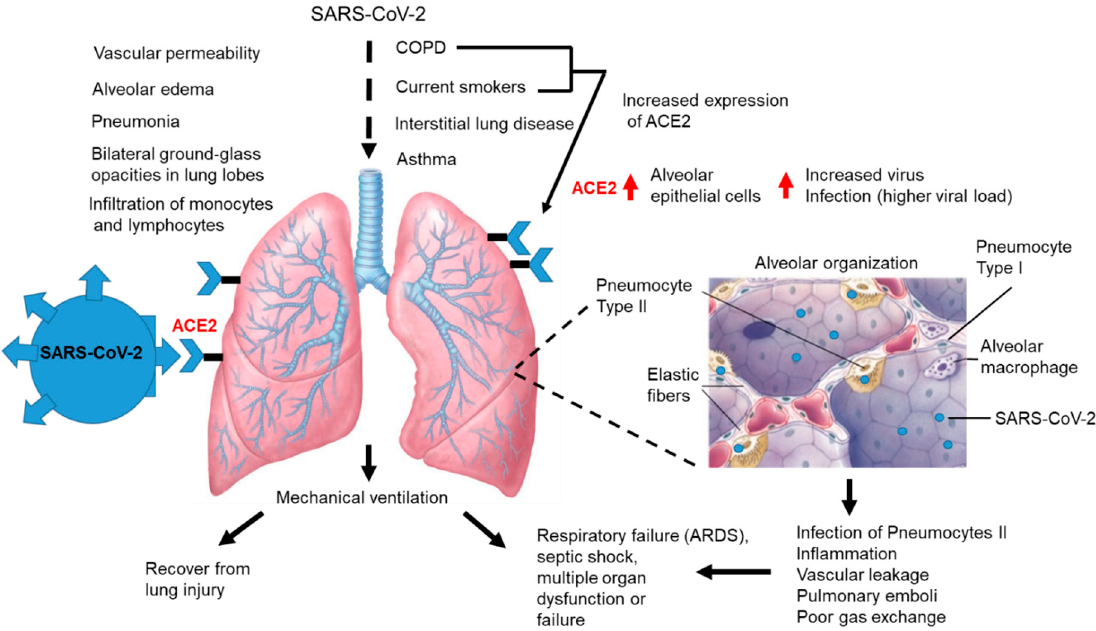
Figure 4. Lung disease and increased risk for severe COVID-19 disease. Hypothetical model of patients with pulmonary disease and increased risk for complications due to COVID-19. SARS-CoV-2 infection via ACE2 entry into alveolar epithelial cells in patients with COPD who smoke may lead to increased surface-expression ACE2 on lung epithelium that may increase the rate of infection in the lung and contribute to higher viral loads. Shown is the alveolar organization and resident cells that include pneumocytes Type I, pneumocytes Type II and alveolar macrophages. Elastic fibers are also shown and SARS-CoV-2 particles are shown as blue ovals. Alveolar cells pneumocytes type II are highly permissive for SARS-CoV-2 infection resulting in alveolar dysfunction, inflammation, vascular leakage, development of pulmonary emboli, and acute respiratory distress from poor gas exchange. Progressive viral infection and potential cytokine storm leads to pulmonary vascular leakage, alveolar edema, and monocyte infiltration at sites of infection, resulting in reduced lung function. Patients often require mechanical ventilation increasing the risk of delayed recovery, respiratory failure, septic shock, and MOD or failure. ARDS (Acute respiratory distress syndrome).